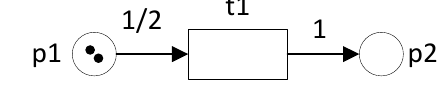
Fig. 4. Petri net with a fractional value The Petri net in fig.4 indicates that the input value is 0.25 or one fourth of a token. The incidence matrix is represented